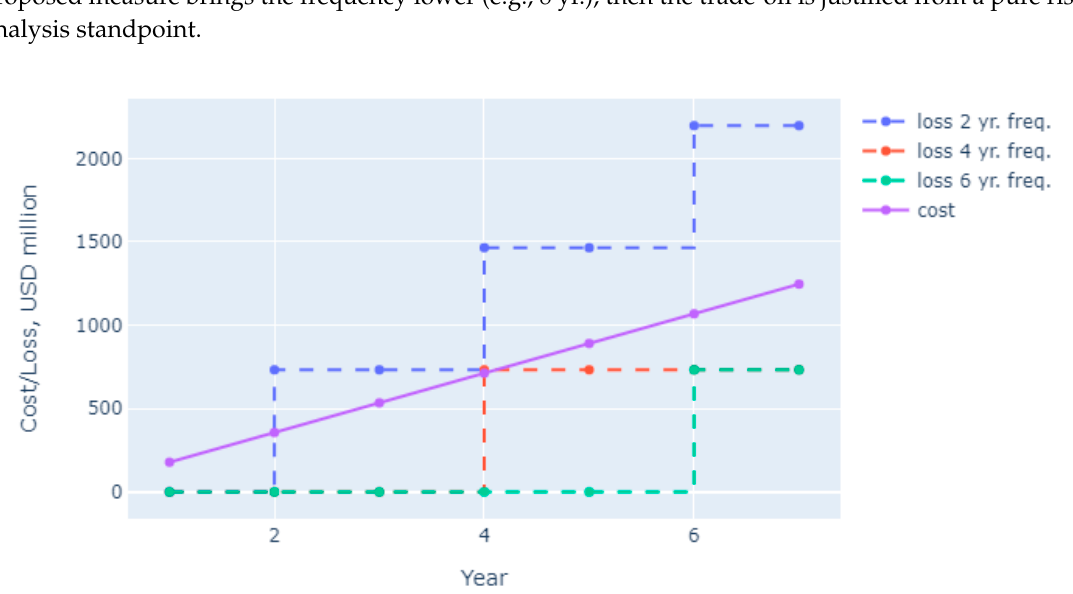
pay, WTP; value of mortality risk, VMR. WTP; value of mortality risk, VMR.